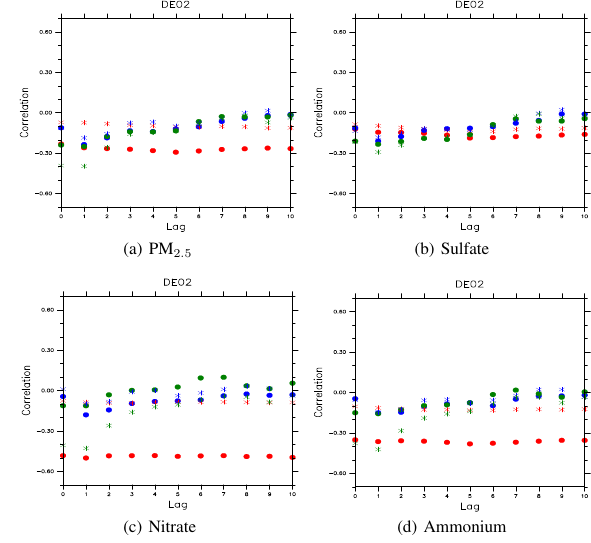
Fig. 5. Correlations between meteorology (temperature in red, pre- Fig. 5 : Correlations between meteorology (temperature in red, precipitation in blue, wind speed cipitation in blue, wind speed in green) on a given day and pollutant in green) on a given day and pollutant concentrations (PM 2 . 5 , sulfate, nitrate and ammonium), concentrations (PM 2 . 5 , sulfate, nitrate, and ammonium), ranging up ranging up to 10 days after at DE02 (2006-2008). Simulated data are represented with a star, while observational data are represented with a dot. to 10 days after at DE02 (2006–2008). Simulated data are repre- sented with a star, while observational data are represented with a dot.